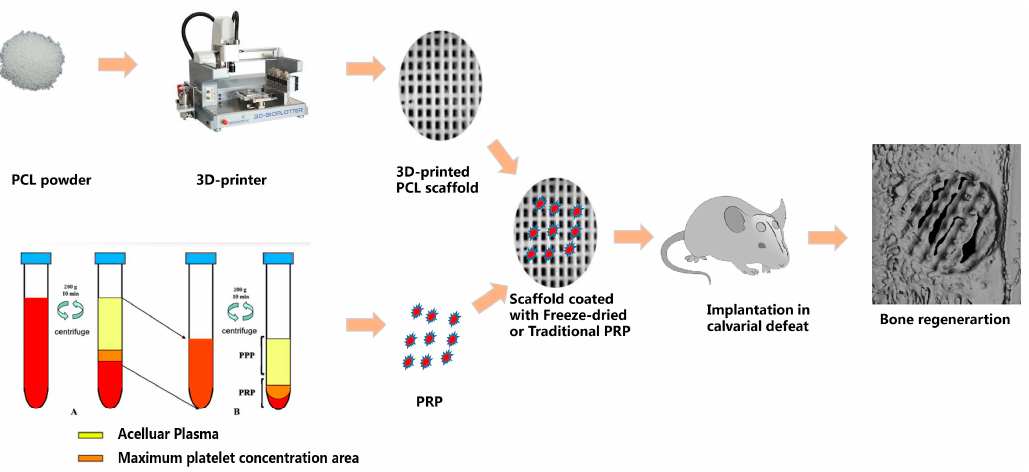
Figure 1. An overview of the in vivo bone regeneration of the calvarial defects.